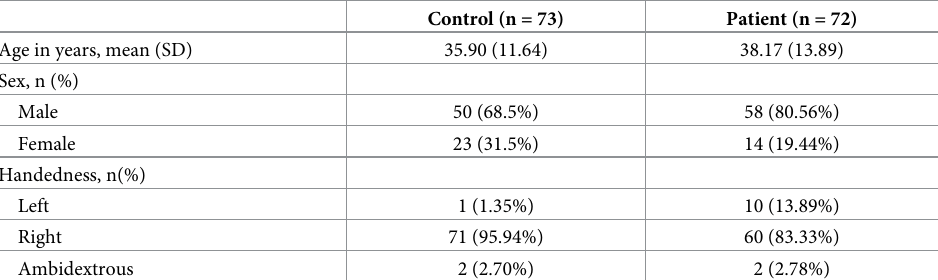
Table 1. COBRE dataset subject